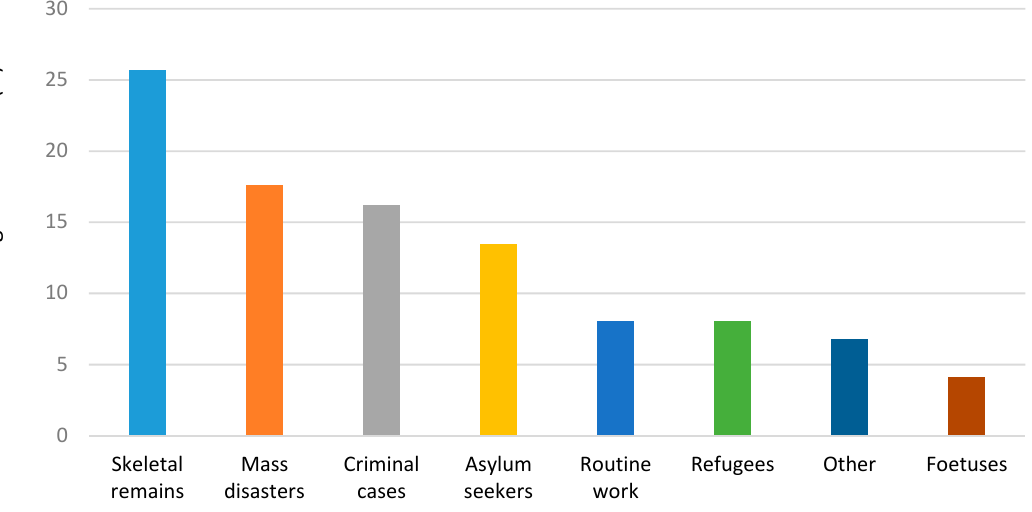
Figure 1. Reasons for age estimation requests (%).